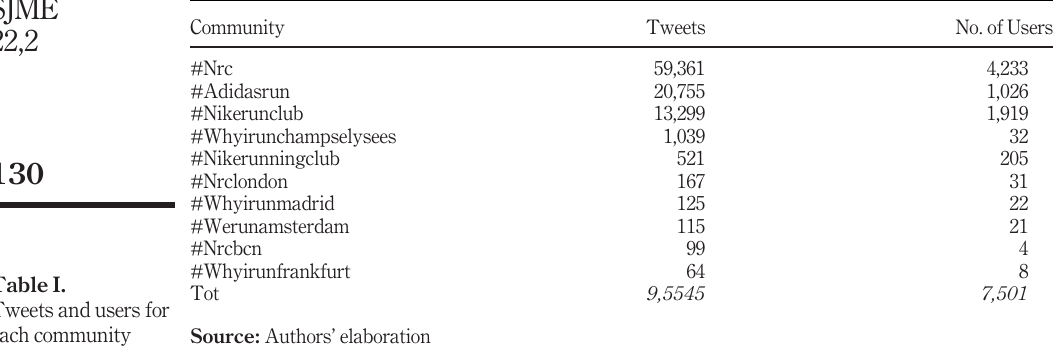
Table I. Tweets and users for each